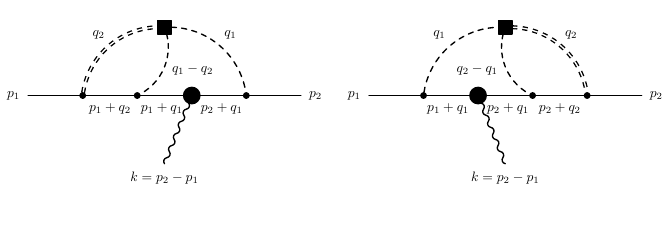
Figure 2. Detailed diagrams c) and d) from Fig.1 where the external field couples to the proton